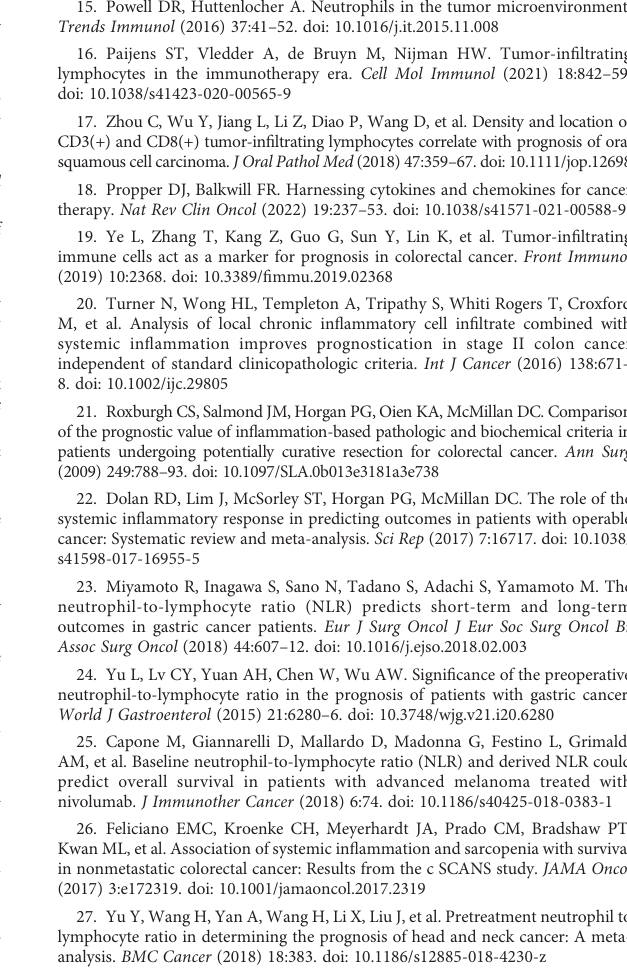
SUPPLEMENTARY FIGURE 1 Distribution plot of pNLR in the clinical cohort. The distribution plot of pNLR in the multicenter clinical cohort (n = 599). SUPPLEMENTARY FIGURE 2 Prognostic analysis of the reduced model. ROC and Kaplan – Meier OS curves of the reduced model (b, including age and pathology N stage) on OS at 1 – 5-year follow-up. SUPPLEMENTARY FIGURE 3 Distribution plot of pNLR in clinical IHC cohort. The distribution plot of pNLR in the clinical cohort for further IHC validation (n =